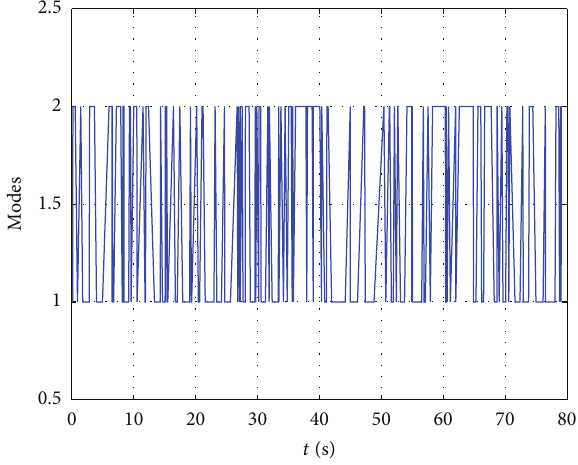
Figure 3: Operation modes of Example